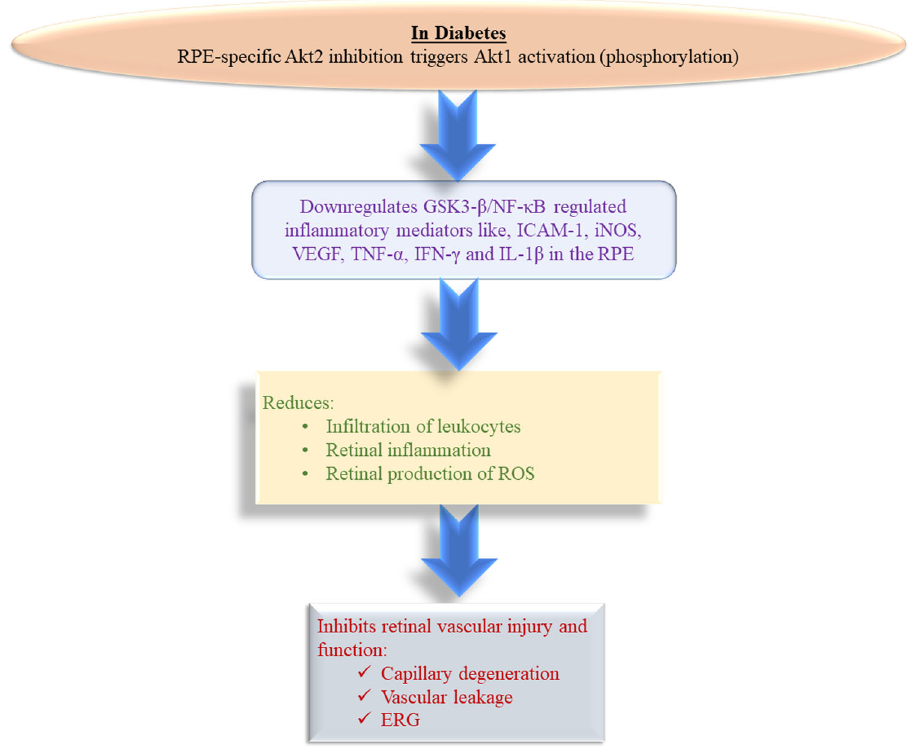
Fig. 10 | Schematic. RPE-speci fi c Akt2 cKO reduced the diabetes-mediated induc- tion of the in fl ammatory protein level, in fi ltration of leukocytes and production of ROS in the retina after a 2 month duration of diabetes. Akt2 cKO also showed reduction in retinal capillary degeneration and vascular leakage even after an